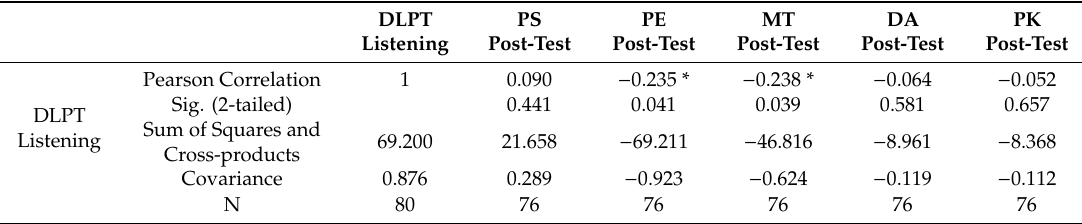
Table 9. Correlations between DLPT listening proficiency and the MALQ